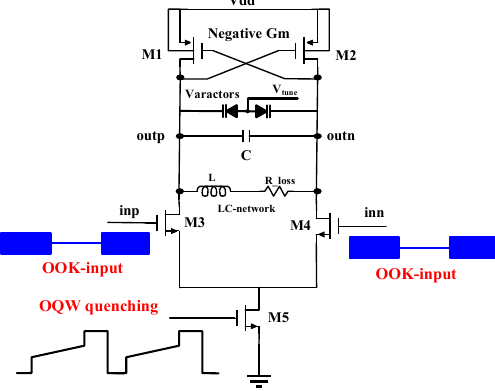
Figure 4. The conventional SRO architecture with OQW.